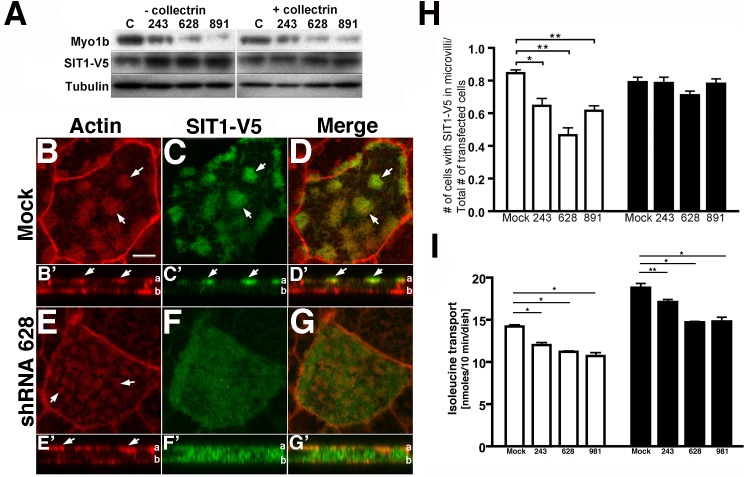
Myo1b kd reduces the number of SIT1 transporters at the apical plasma membrane.OK cells were transfected with SIT1-V5 and either collectrin or empty vector (pLenti-CMV Hygro) and stained with rhodamine phalloidin to visualize the apical microvilli. A, Immunoblot showing that Myo1b kd increased SIT1-V5 expression. Tubulin served as a loading control. B-G, B’-G’, Sample images showing that in control (Mock) OK 3B/2 cells (B-D; B’-D’), expressed SIT1-V5 (C, green) localized almost exclusively in actin-rich microvilli (B, red; arrows) on the apical surface; whereas in Myo1b kd-cells (shRNA 628) (E-G; E’-G’), SIT1-V5 localized to the cytoplasm. Cytoplasmic SIT1-V5 in Myo1b-kd cells is most evident in the lateral (x-z) view shown in F’. B-G are x-y images; B’-G’ are x-z images of B-G, respectively. In B’-G’, the position of the apical membrane is marked with a, and the position of the basal membrane is marked with b. D, D’, G, G’, Merge, yellow. Bar, 5 μm. H, Myo1b-kd decreased the number of cells expressing SIT1-V5 at the APM. The number of transfected cells with SIT1-V5 in apical microvilli was determined and expressed as a function of the total number of transfected cells. In each case 167–465 transfected cells were counted. The data are from three independent experiments and expressed as means ± s.e. *P<0.01, ** P<0.005. The expression of exogenous collectrin rescued the Myo1b-kd-induced decrease in SIT1-V5 at the APM. The number of cells expressing SIT1-V5 at the APM was not statistically different in control vs. Myo1b-kd cells when collectrin was overexpressed; P>0.05. I, [3H]isoleucine transport was not rescued in Myo1b-kd cells by collectrin. Overexpression of exogenous collectrin in Myo1b-kd cells did not rescue neutral amino acid transport. White filled bars, (-) collectrin; black-filled bars, (+) collectrin. Data are means ± s. d. for samples done in triplicate. * P<0.005, ** P<0.001.